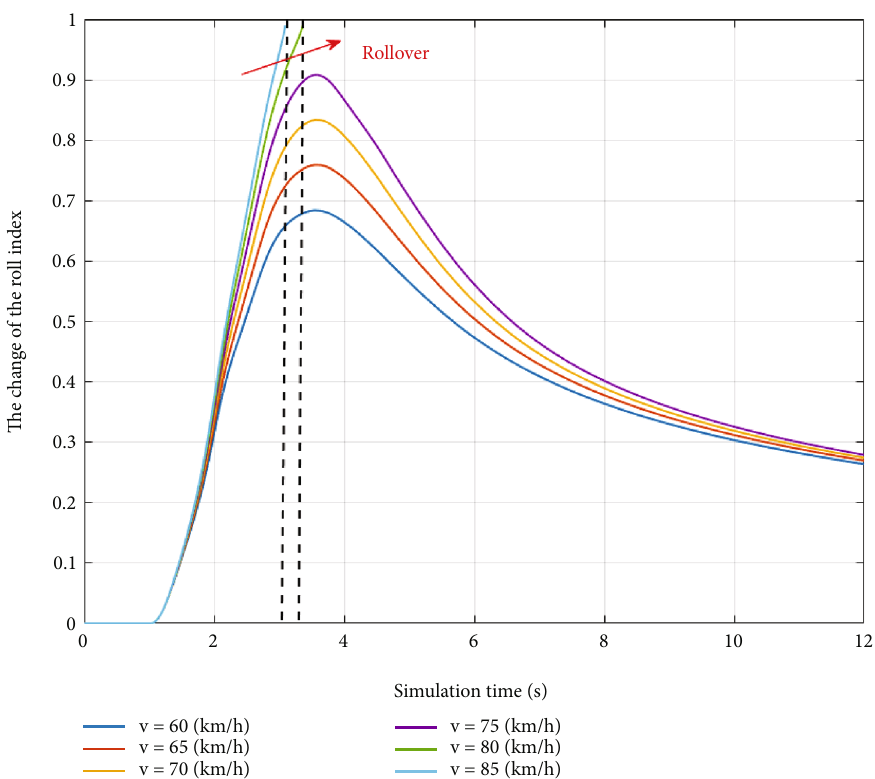
Figure 9: The change of the roll index (the second case — velocity change).